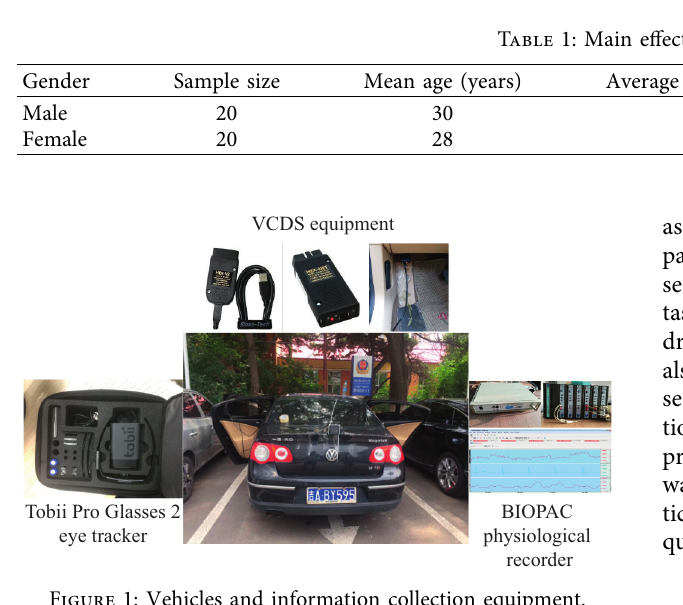
Figure 1: Vehicles and information collection